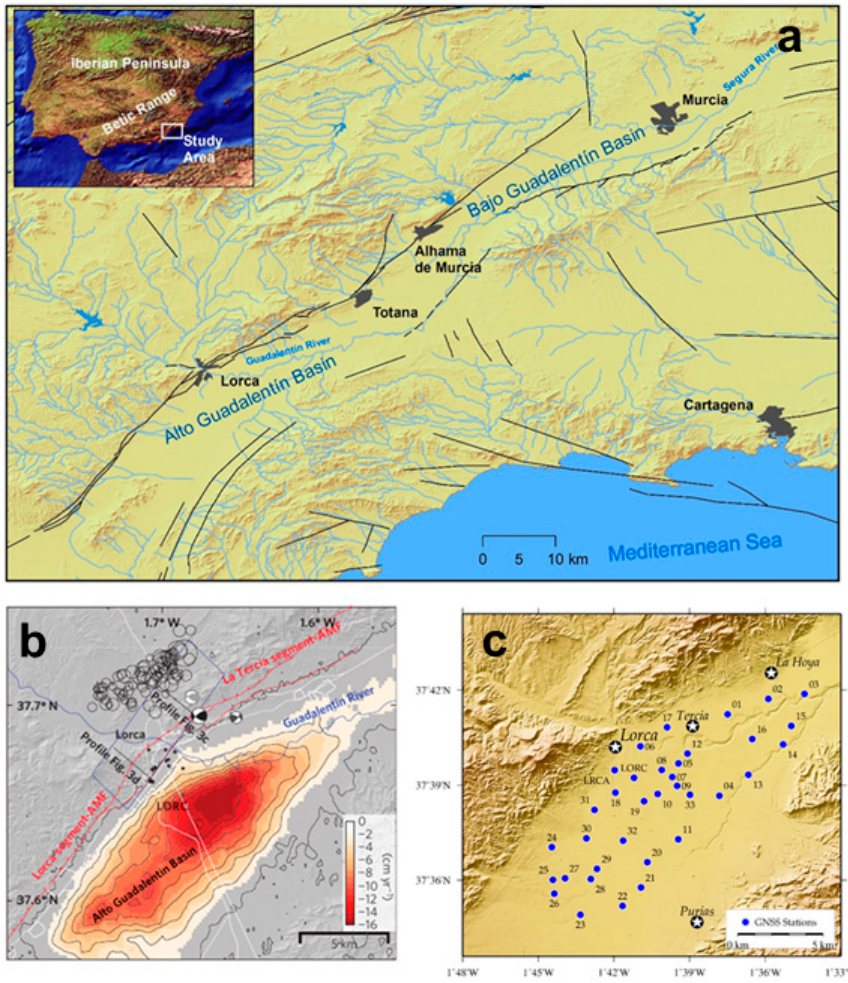
Figure 22. ( a ) Location of the Alto Guadalent í n Basin, the Bajo Guadalent í n Basin and the Guadalent í n River that formed the two basins. Black lines depict main faults in the area. The locations and names of the main cities in the area are shown. The topography has been obtained from MDT05 2015 CC-BY 4.0 digital elevation model [111]. ( b ) Subsidence area detected in previous studies31 by means of DInSAR techniques along the Alto Guadalent í n Basin. Subsidence rates have a maximum of 16 cm / yr for the period 2006–2011 located ~4 km south-west the city of Lorca. The black stars are damage locations due to the M = 5.1 May 2008 Lorca earthquake. Red lines are main faults (AMF, Alhama de Murcia Fault). The contour lines indicate 2 cm / yr DInSAR subsidence due to groundwater pumping. ( c ) Location of the monitoring GNSS control stations deployed in the area of Alto Guadalent í n. The network consists of 33 monitoring stations (blue circles show their location) and covers an area of about 70 km 2 . The network is designed to allow high accuracy GNSS surveys and also includes two existing continuous GNSS stations. Main population centers are depicted with white stars. Modified from